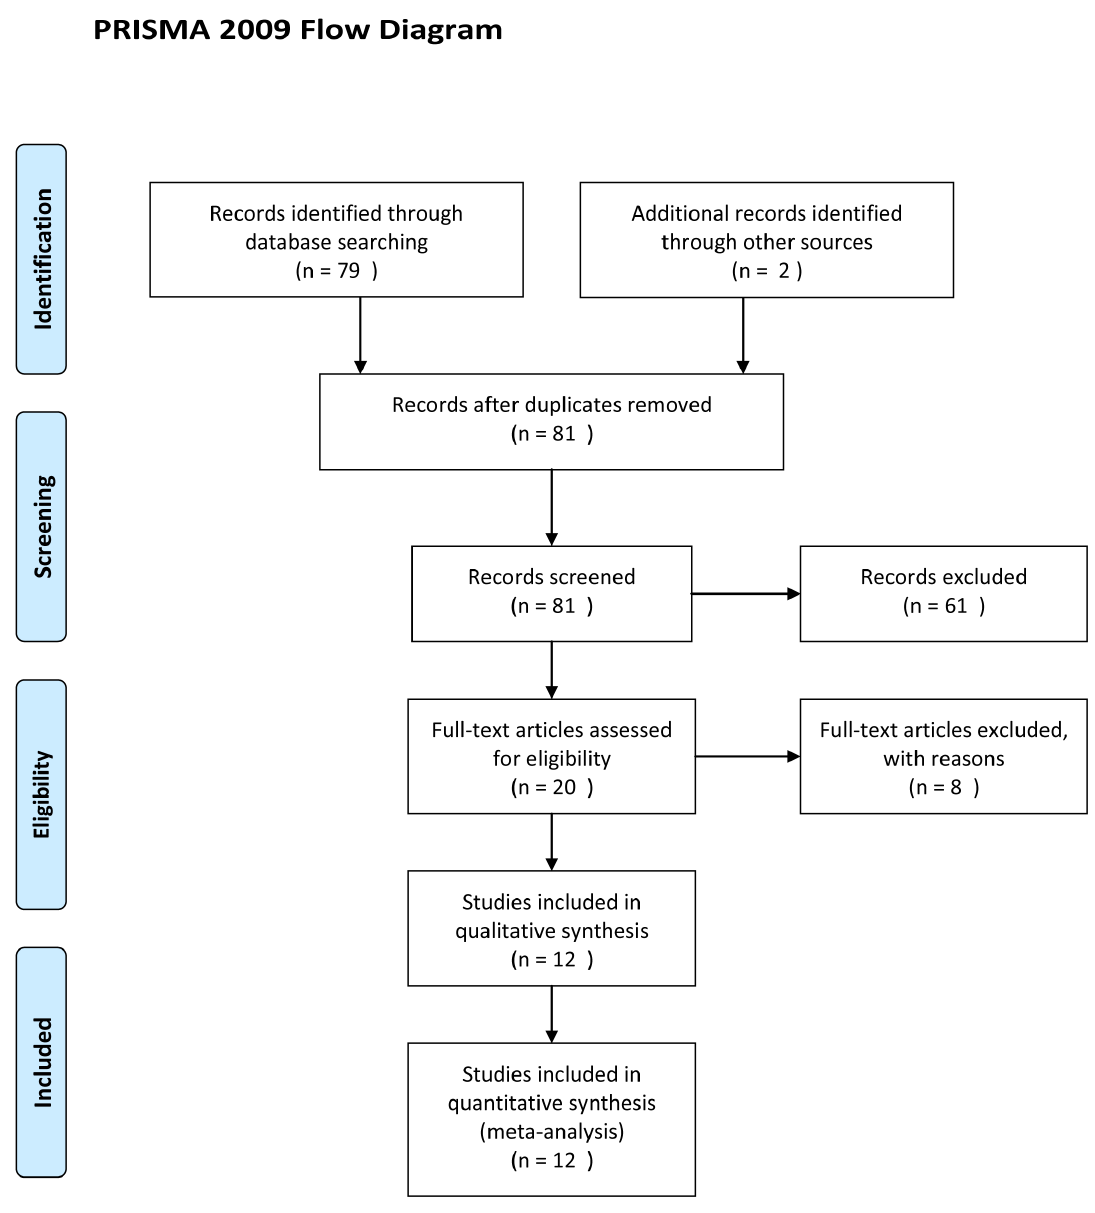
Figure 1. Flowchart of the study selection.